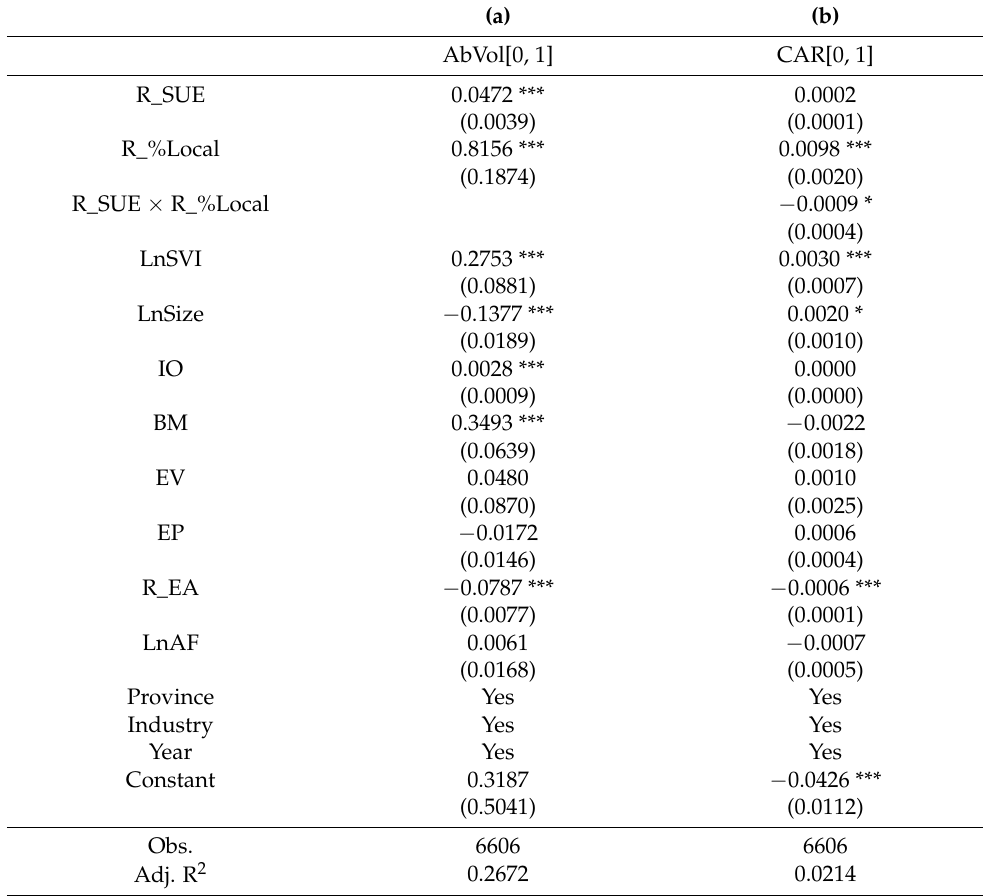
Table 5. Local Attention and Market Response at the Earnings